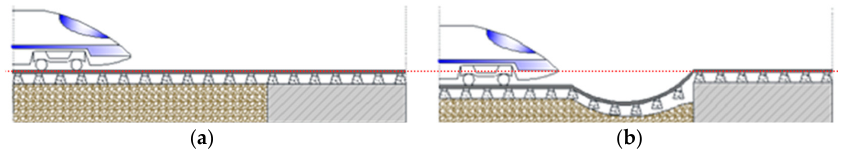
Figure 2. Schematic diagram of differential settlement in transition zone: ( a ) immediately after construction or maintenance; ( b ) after a few months of operation.